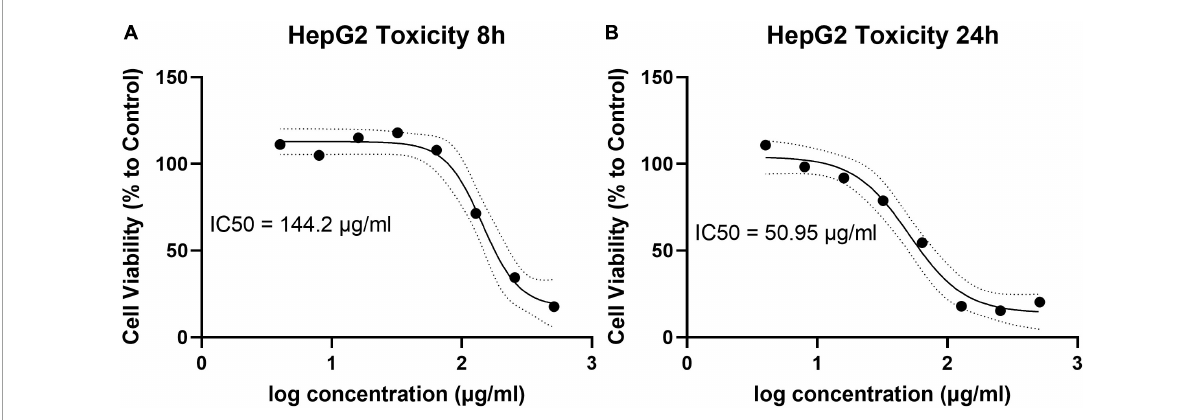
FIGURE3 AHA-1394 HepG2 cytotoxicity and IC 50 . Log AHA-1394 concentration was plotted against the percentage of live HepG2 cells at (A) 8 h and (B) 24 h following normalization of HepG2 cells incubated without AHA-1394. The IC 50 was calculated according to standard curve interpretation and defined as the concentration responsible for 50% HepG2 cell death.